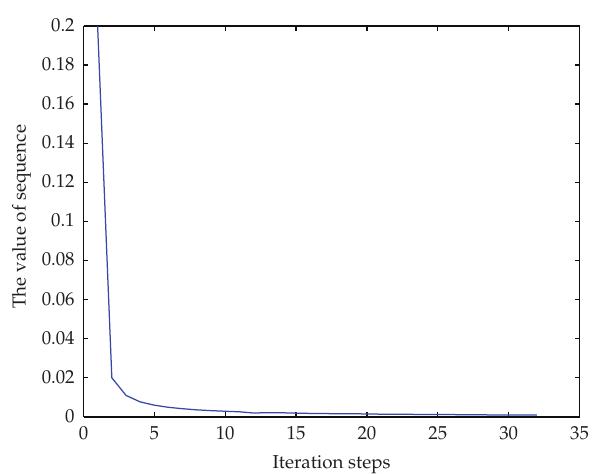
Figure 1: The corresponding graph at x (cid:5) 0 .